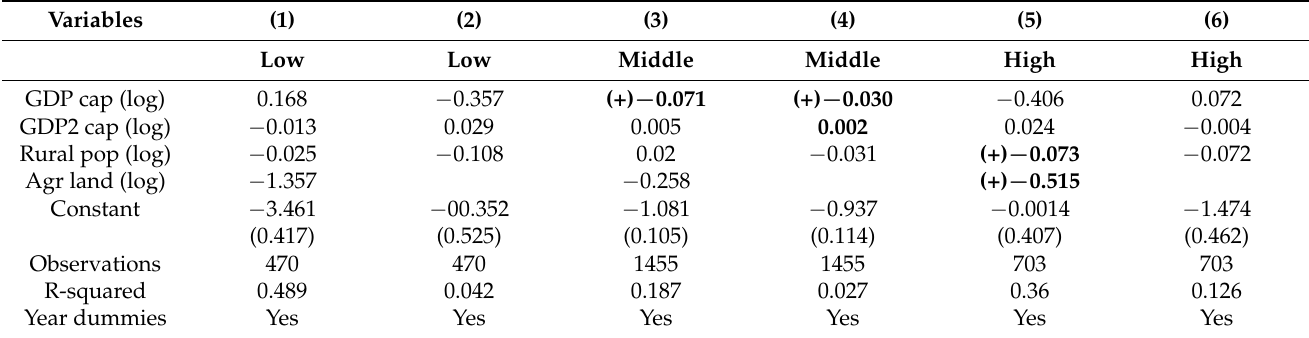
Table A10. Long-run results, income clusters.